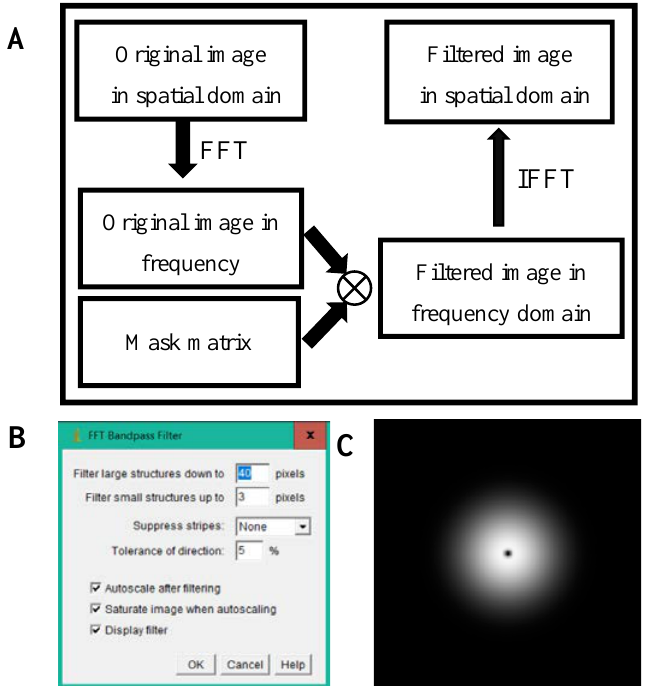
Figure 5. ( A ) The generalization process of bandpass filter based on fast Fourier transformation (FFT). ( B ) The parameters of the mask matrix with Image J software. ( C ) The mask matrix of the bandpass filter generated by Image J software.